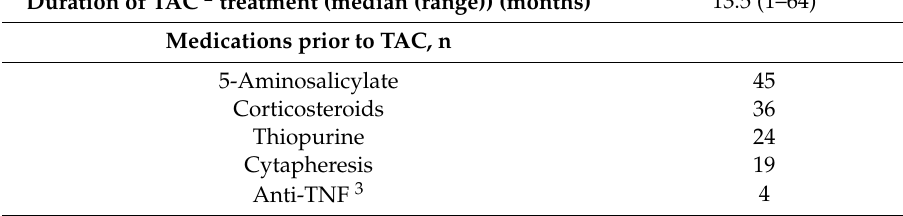
Duration of TAC 2 treatment (median (range)) (months)